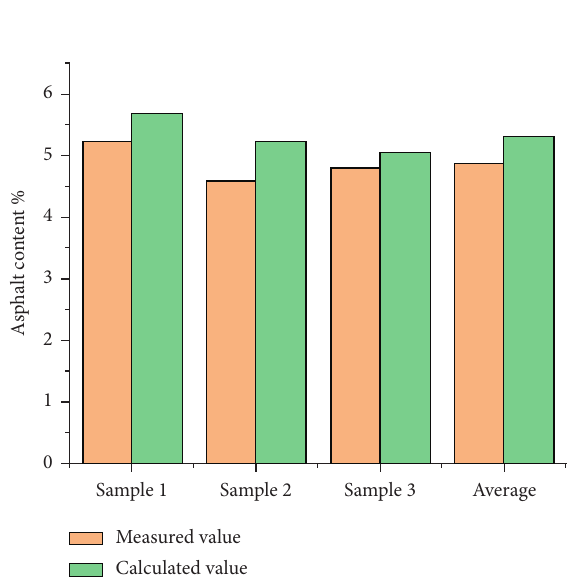
Figure 8: Comparison between the measured value and the cal- culated value of pavement sampling.